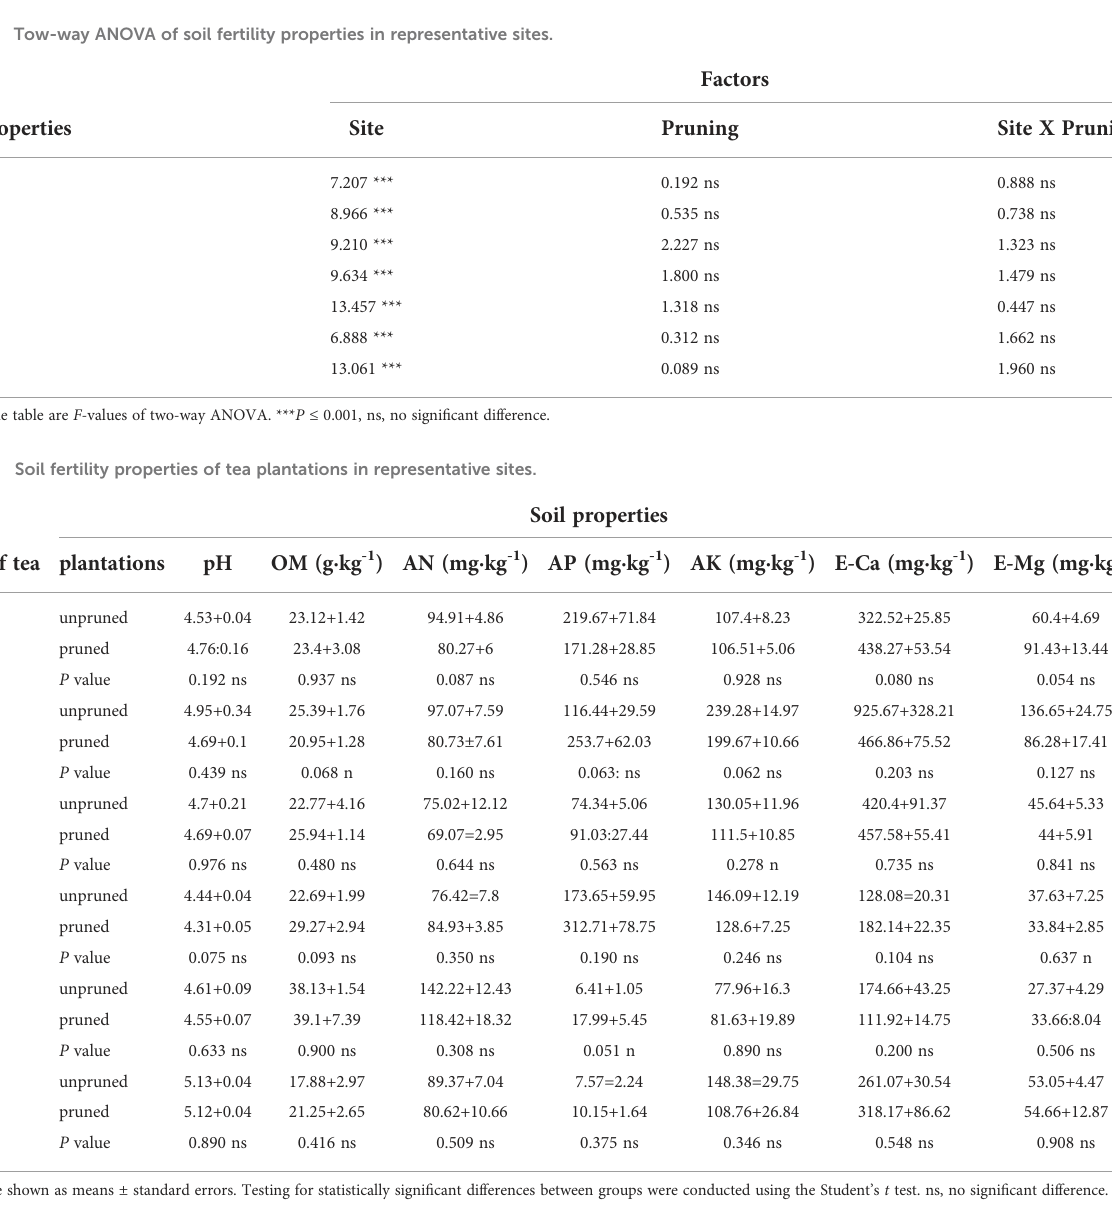
(Table 2). There were no signi fi cant differences in soil fertility